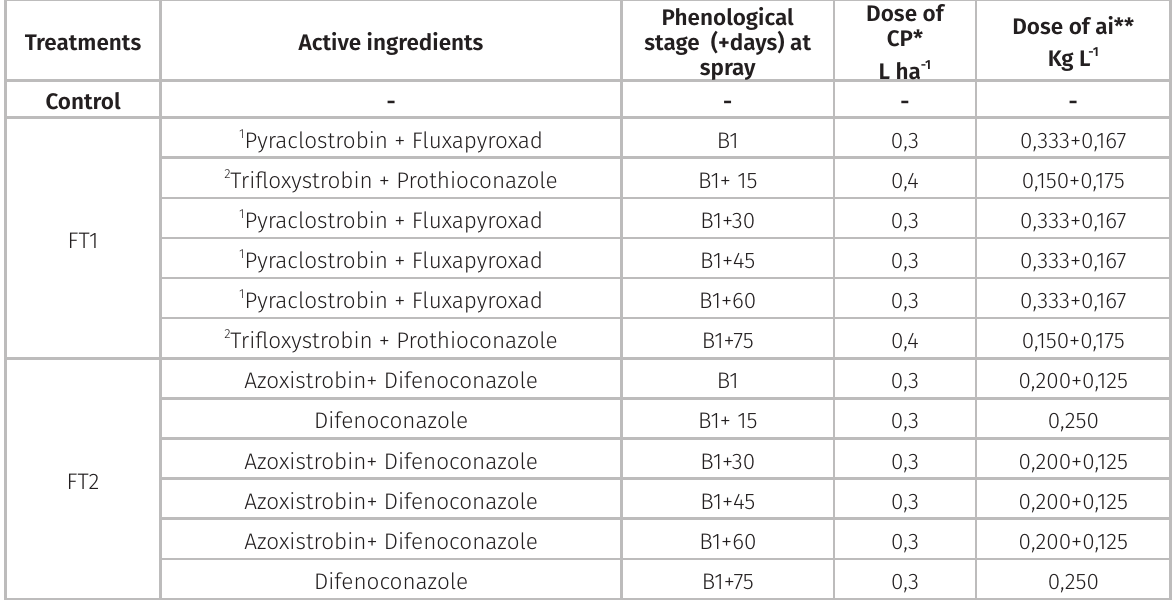
Table I. Description of fungicide treatments used at work. Chapadão do Sul, MS. Crop season: 2014/15.